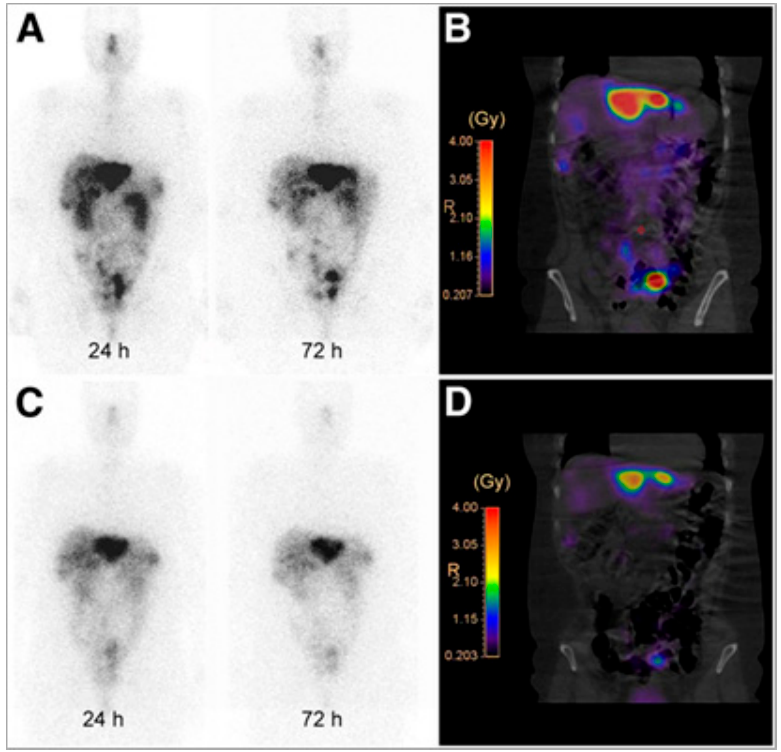
Figure 2. Comparison 177 Lu-DOTA-JR11 and 177 Lu-DOTA-TATE in a female patient with neuroendocrine tumor of the ileum. The figure presents planar scans and isodose curves after administration of 850 MBq of 177 Lu-DOTA-JR11 ( A , B ) and 990 MBq of 177 Lu-DOTA-TATE ( C , D ). Planar scans ( A , C ) show results 24 and 72 h after injection of 177 Lu-DOTA-JR11 and 177 Lu-DOTA-TATE. This research was originally published in JNM . Reproduced from [32]. © By the Society of Nuclear Medicine and Molecular Imaging, Inc.